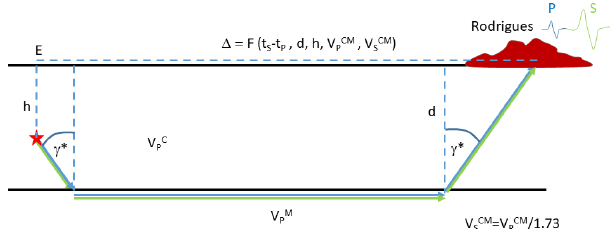
Figure 4. Cartoon depicting the model employed to estimate epicentral distances from travel-time differences between S and P wave arrival. The simple 1-D velocity model of the oceanic crust and uppermost mantle consists of a uniform layer overlying a uni- form half-space. The parameters are set as follows: thickness of the crust, d = 10km; hypocentral depth, h = 6km; P wave veloc- = 6 . 1kms − 1 ; P wave velocity in the mantle, ity in the crust, V C P = 7 . 9kms − 1 ; V P /V S = 1 . 80 in both the crust and mantle. Fig- V M P ures S1 and S2 in the Supplement show the influence of these pa- rameters on the determination of the epicentral distance.